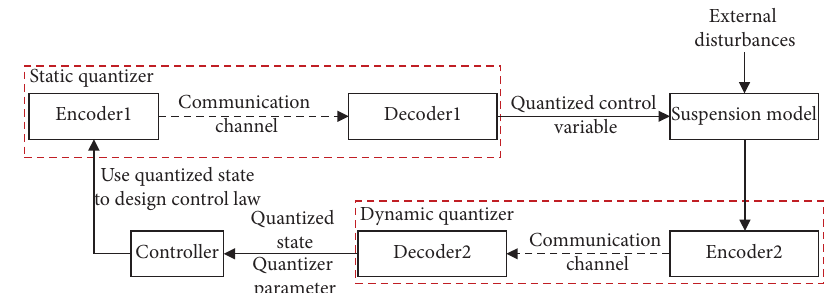
Figure 3: Flow chart of the quantization